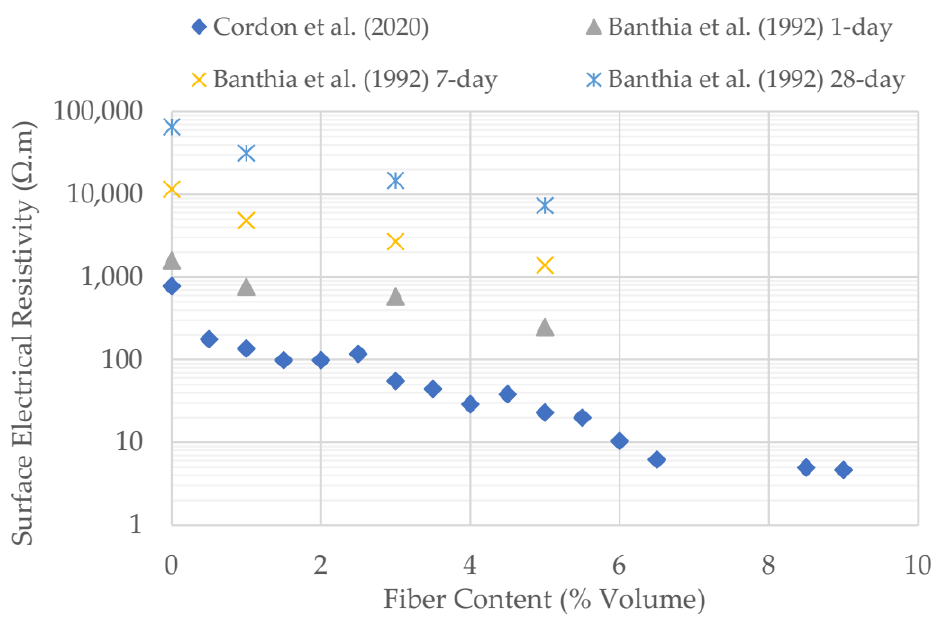
Figure 1. Surface electrical resistivity of selected experimental data [43,49]. Table 1. Selected experimental studies on the electrical resistivity of fiber-reinforced